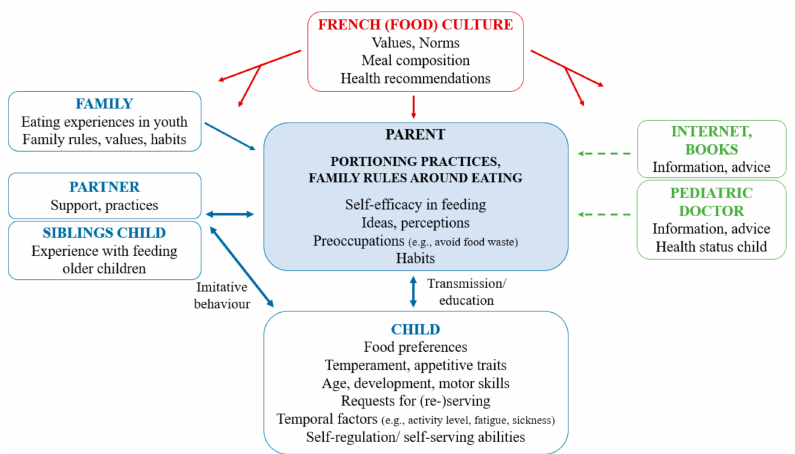
Figure 1. Schematic overview of parent-related factors, child-related factors and external factors influencing parental portioning practices and general feeding practices. Dotted lines indicate a minor